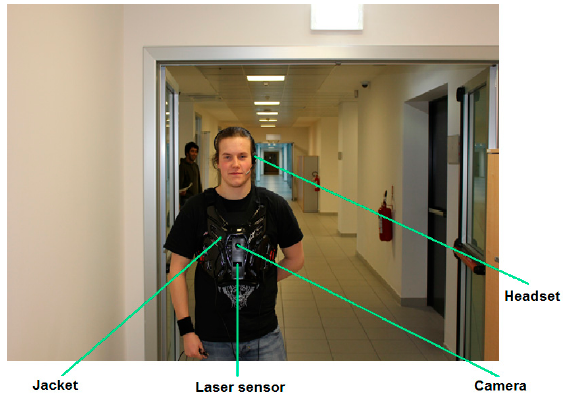
Figure 7. View of the wearable prototype with its main components.